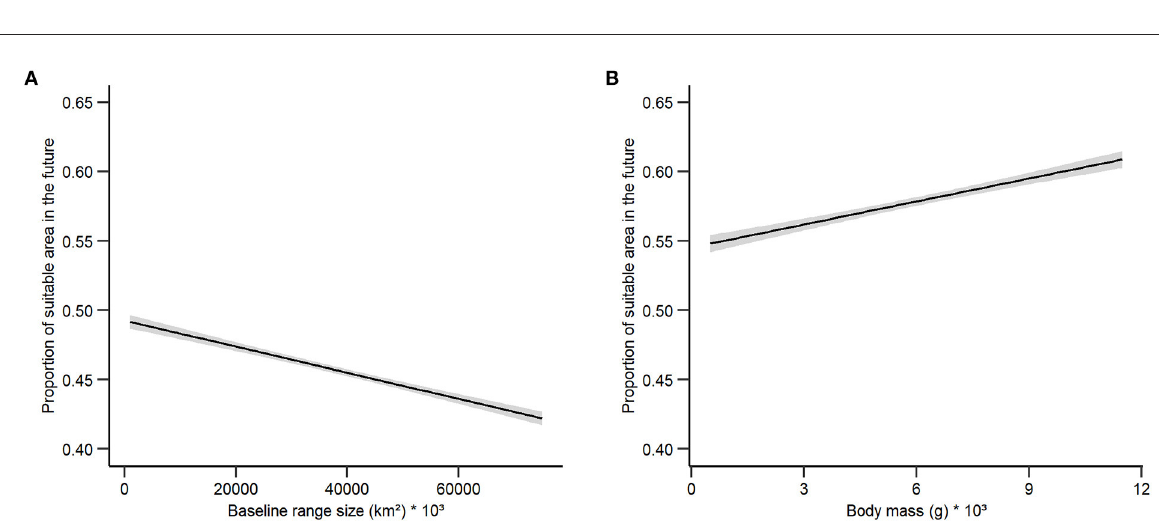
FIGURE3 Relationship between the proportion of birds’ suitable area in the future and (A) baseline range size, and (B) body mass. The gray area around the line indicates 95% confidence